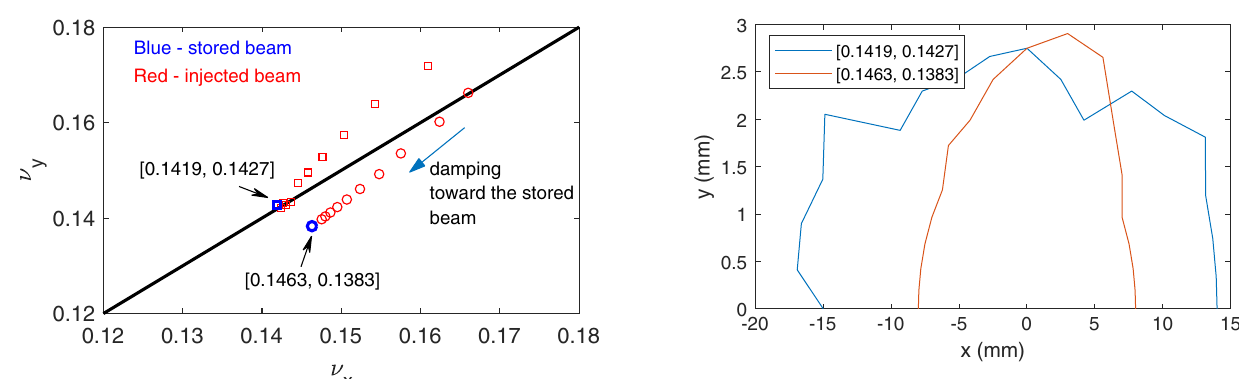
correction ( G ¼ 0 . 00052 ). The two working points are ½ ν ; ν (cid:2) ¼ ½ 0 . 1419 ; 0 . 1427 (cid:2) and [0.1463, 0.1383], respec- x y